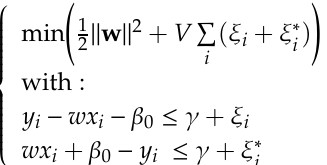
Figure 1. Both processes comprise three main elements: the blank holder, the die, and the punch. The first stage of the forming process consists of reducing the distance between the die and the blank holder, until an imposed force is attained (blank holder force (BHF)). Then, the punch moves to promote the material flow into the die cavity, while the BHF remains constant. The U-Channel forming process ends after a total punch displacement of 30 mm, while the Square Cup forming process ends after a total punch displacement of 40 mm. The last stage consists of the tools removal, which promotes the recovery of the elastic energy stored in the part (springback). The initial dimensions of the blank of the U-Channel and the Square Cup forming processes are, respectively, 150 × 35 × 0.78 mm 3 and 75 × 75 × 0.78 mm 3 . The material is considered orthotropic. Due to material and geometry symmetries, only one fourth of the blank is simulated for the Square Cup deep-drawing process, considering a finite element mesh with 1800, eight-node hexahedral solid elements. For the U-Channel, only half of the blank is considered, and boundary conditions are set to guarantee a plain strain state along the width of the blank, which enables the use of a total of 450, eight-node hexahedral solid